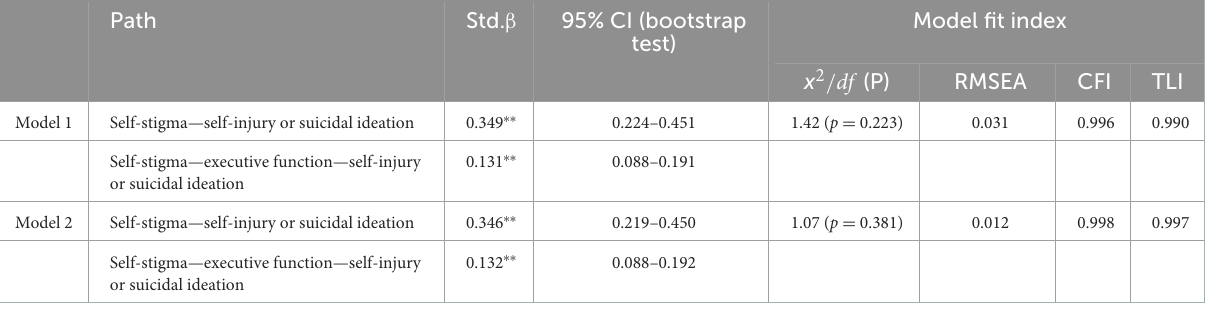
TABLE 3 Parameters of the mediated model of self-stigma and self-injury or suicidal ideation mediated by executive function. Path Std. β 95% CI (bootstrap test)